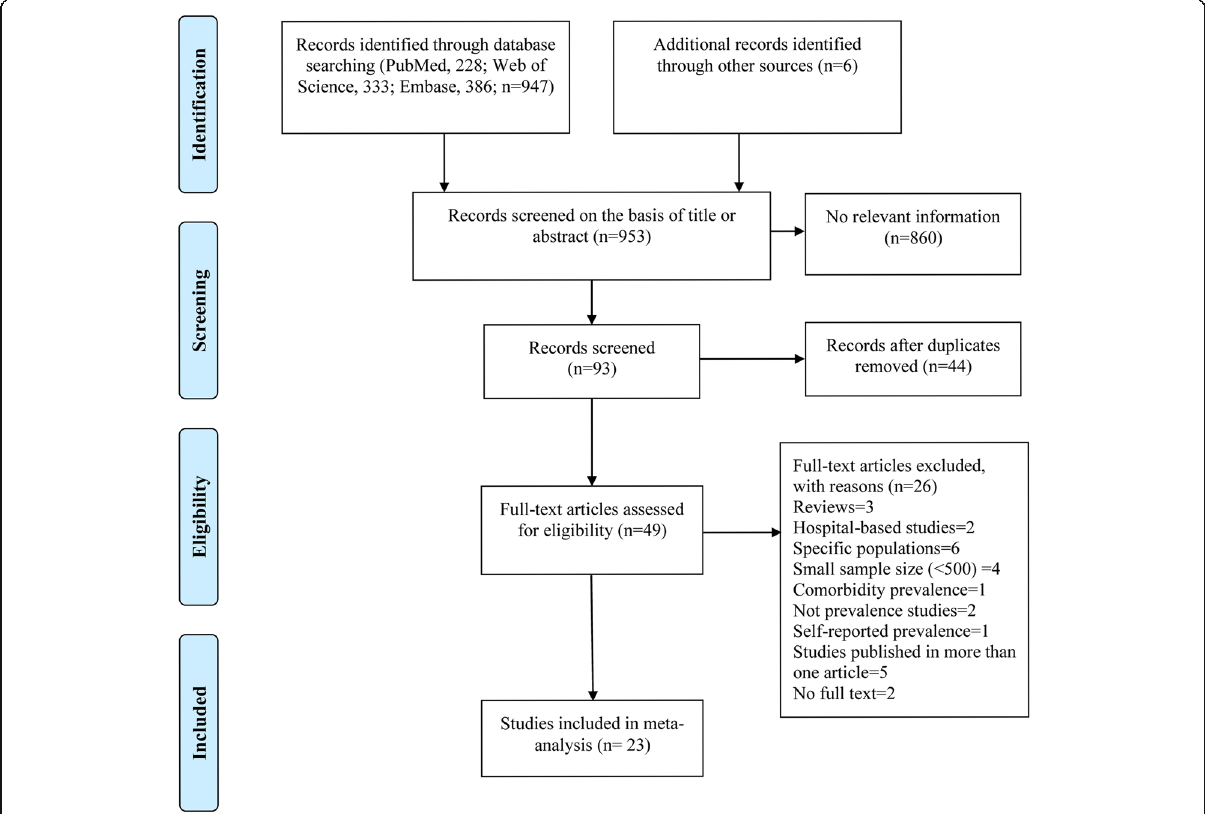
Fig. 1 PRISMA flow diagram of the study selection